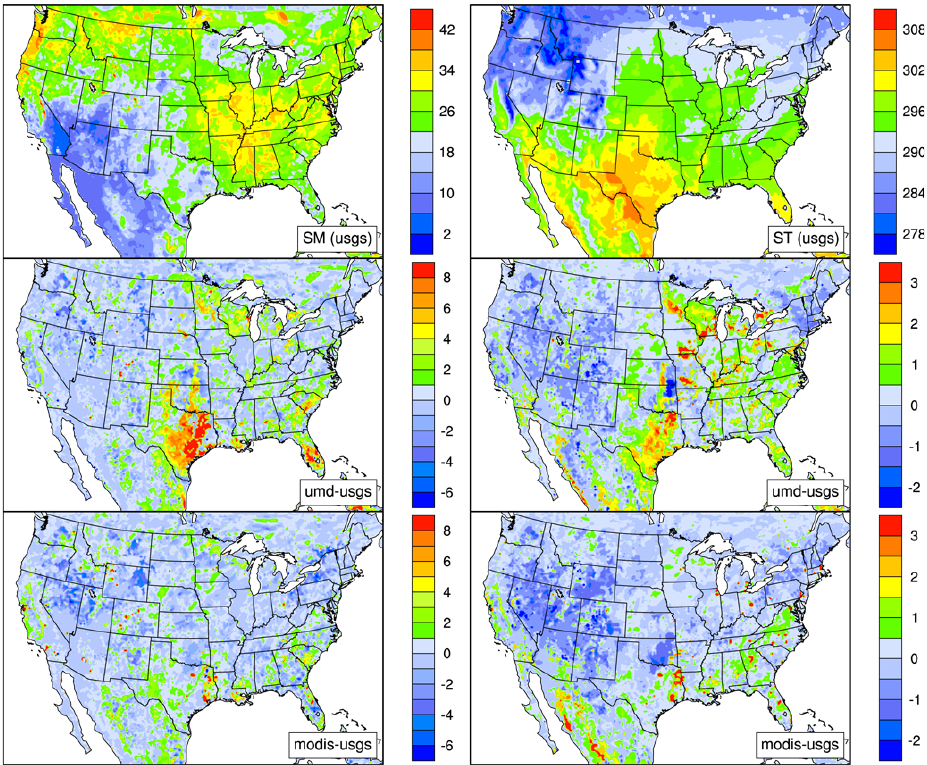
Fig. 3. Spatial distribution of top soil moisture (SM, %, left panels) and average top soil temperature (ST, K, right panels) simulated using the USGS LULC and their differences with the results using the UMD (umd-usgs) and MODIS (modis-usgs)